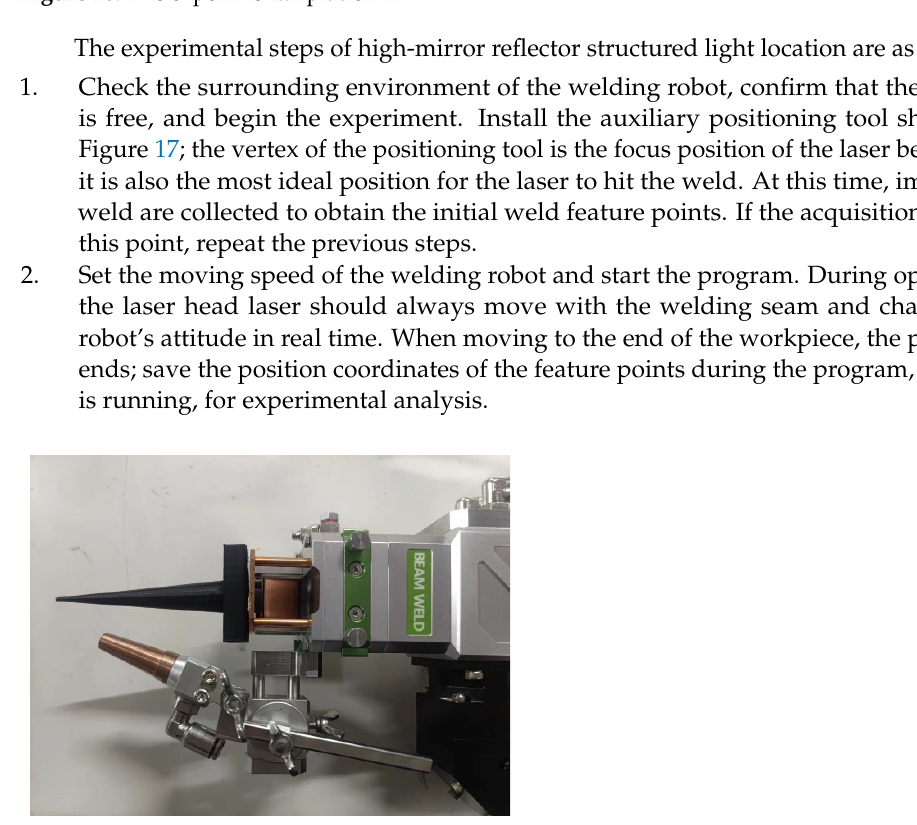
Figure 18. Errors in the weld feature points in the Y and Z directions. Figure 19. The positioning errors of a P and b P . Figure 20. The weld angle error.